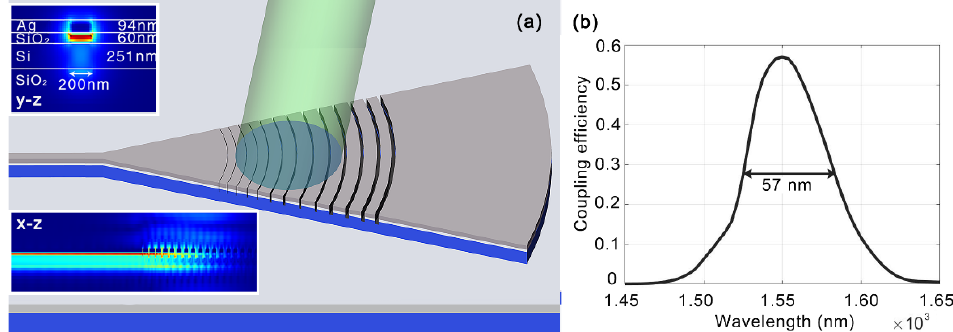
Figure 4. ( a ) 3D schematic of the silicon HPW-fiber coupler. Here, the HPW has a Si stripe and a metal cap. The upper and lower insets show the mode profile of the TM 0 mode of a 200 nm-wide HPW (y-z plane) and the light propagation (x-z plane), respectively. ( b ) Simulated transmission spectrum from the fiber to the 200 nm-wide HPW.